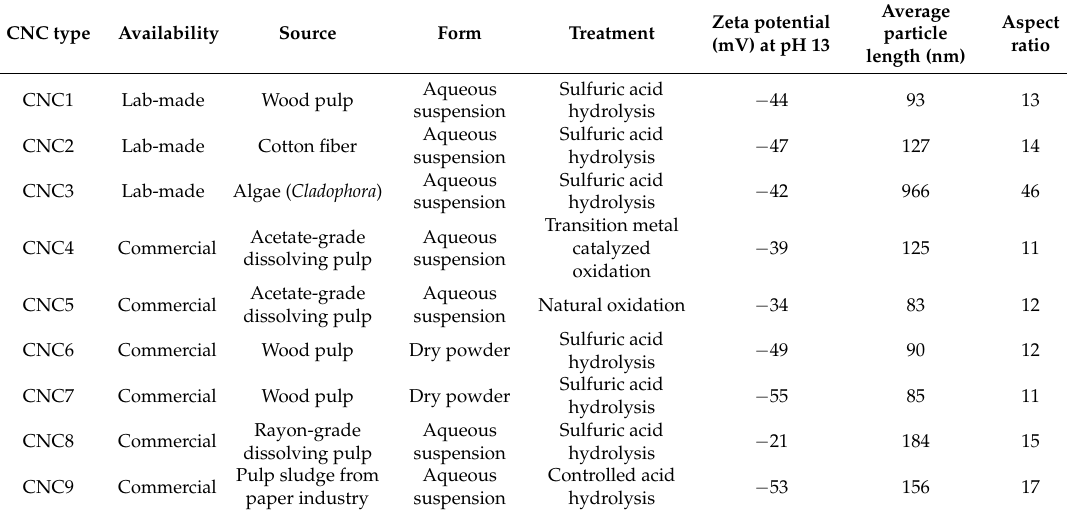
Table 2. Characteristics of cellulose nanocrystals (CNCs)